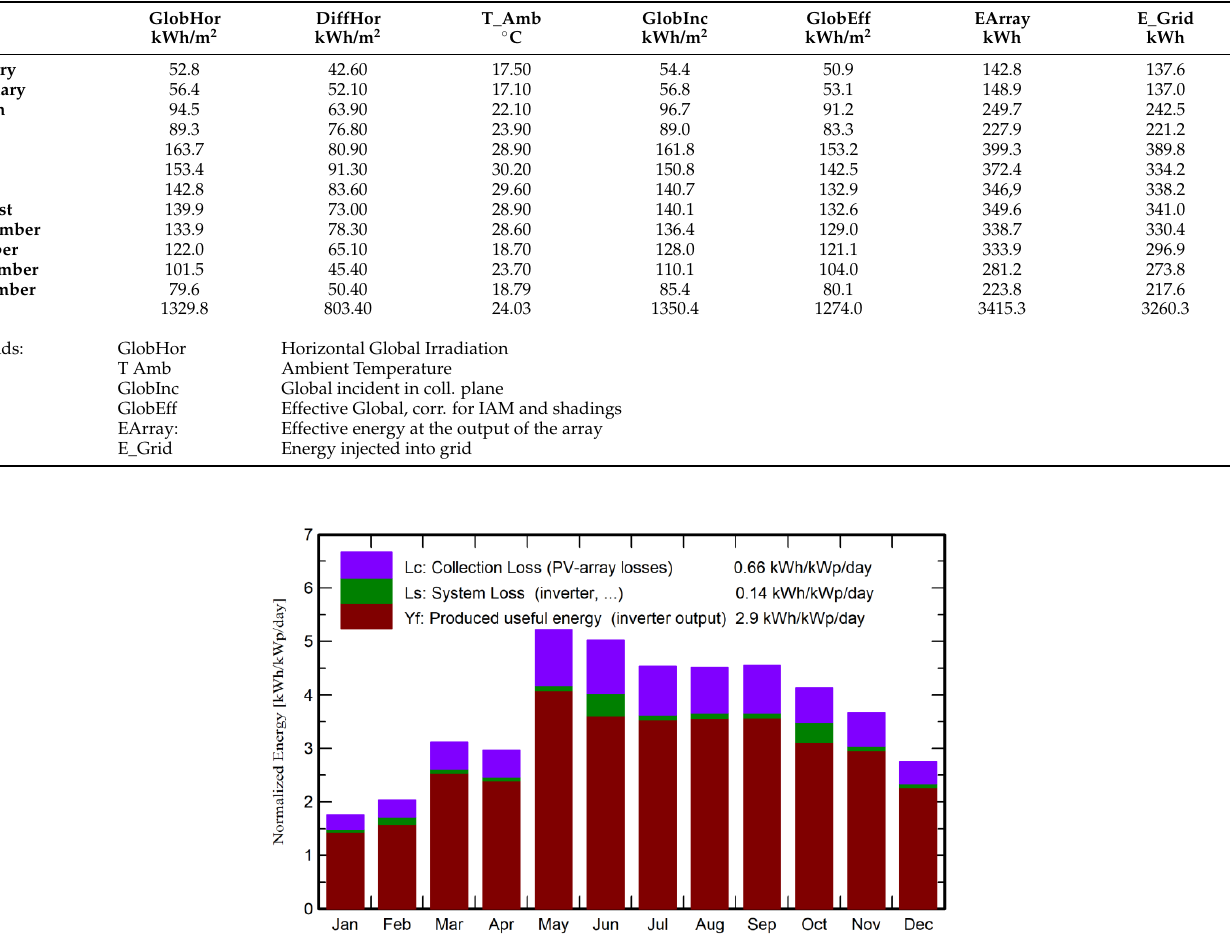
Figure 12. Monthly electricity of simulation results of IES according to weather station of WB. On the other hand, NASA data is used as a secondary source of meteorological data to simulate the PV system of IES (Figure 13). By which, the average generated electricity is 3790.1 kWh/year or 3.37 kWh/kWp/day.